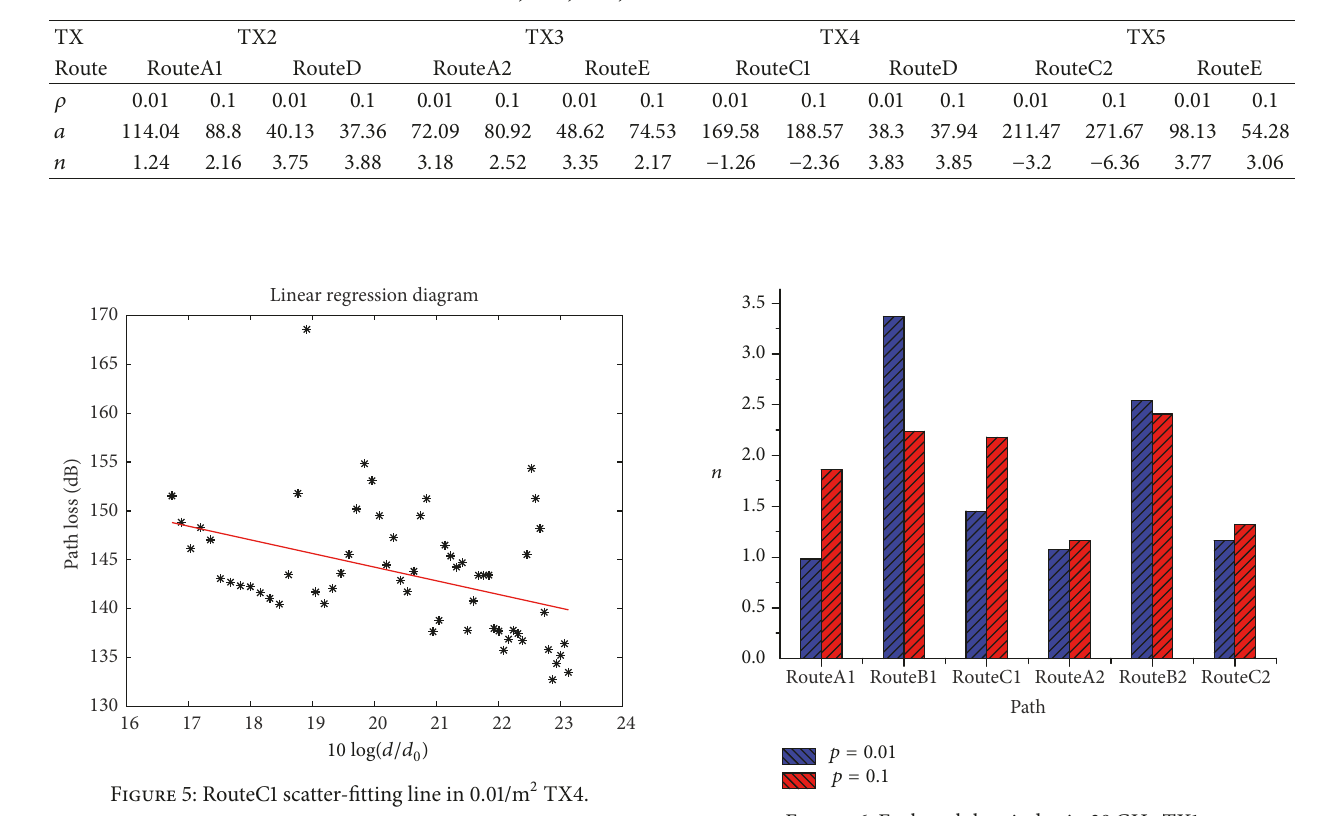
Figure 6: Each path loss index in 38 GHz TX1.